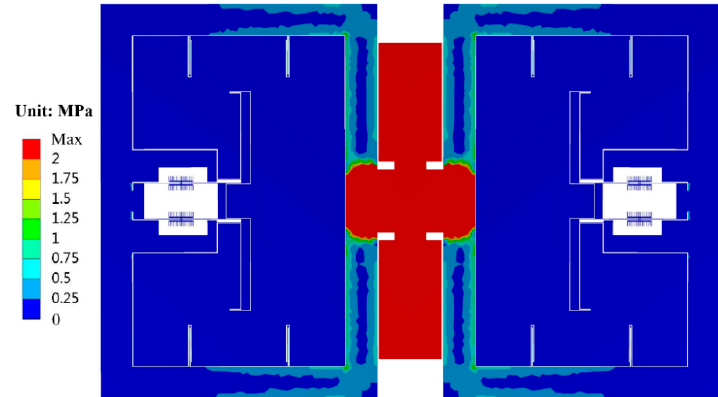
Figure 7. The simulated temperature drift of a single resonator’s natural frequency dominated by the thermal stress in design B.